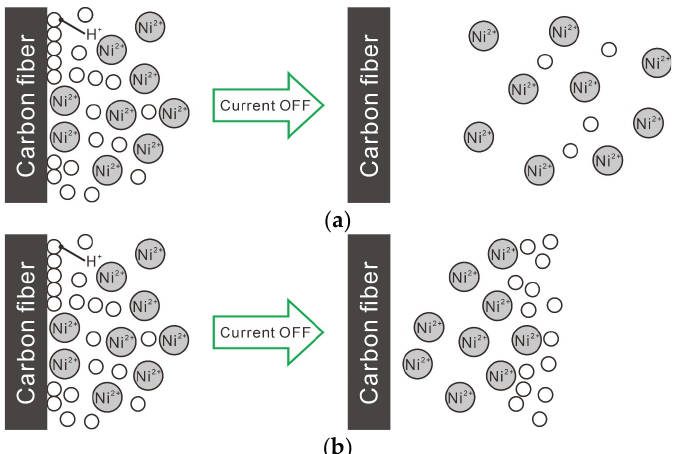
( d ) Figure 15. FE-SEM images of ( a ) D-CNT 10 -CF, ( b ) P-CNT 10 -CF, ( c ) D-CNT 30 -CF and ( d ) P-CNT 30 -CF.